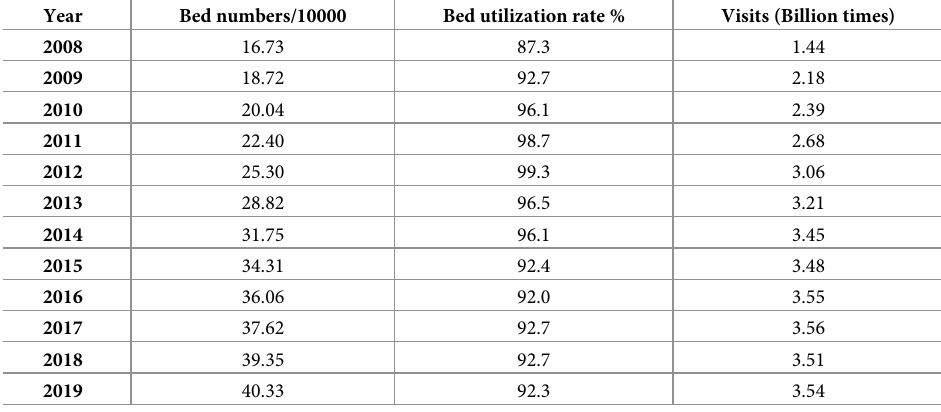
Data source: National Bureau of Statistics (NBS) (China).